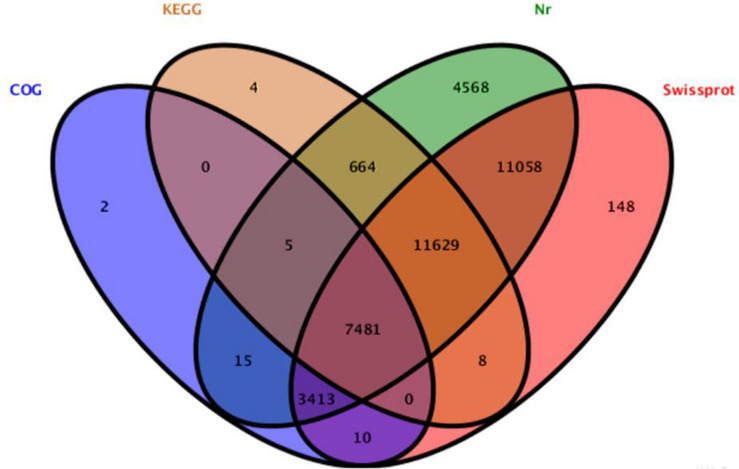
Detection of homologous genes in public databases. The numbers of annotated all-unigenes were indicated in the ellipses respectively.